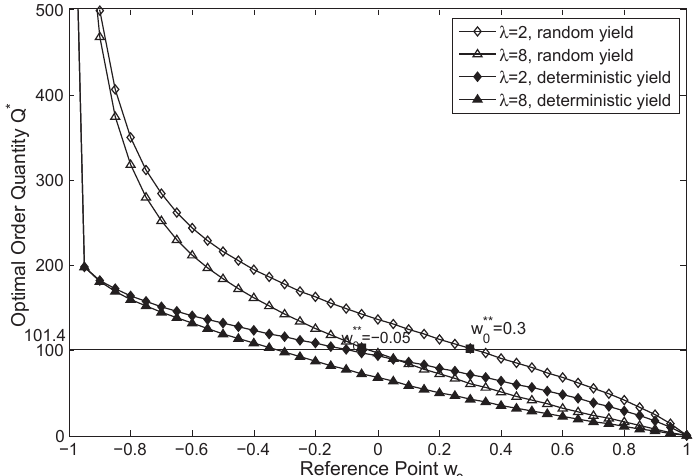
Figure 3. Optimal order quantity vs. reference point under random and deterministic